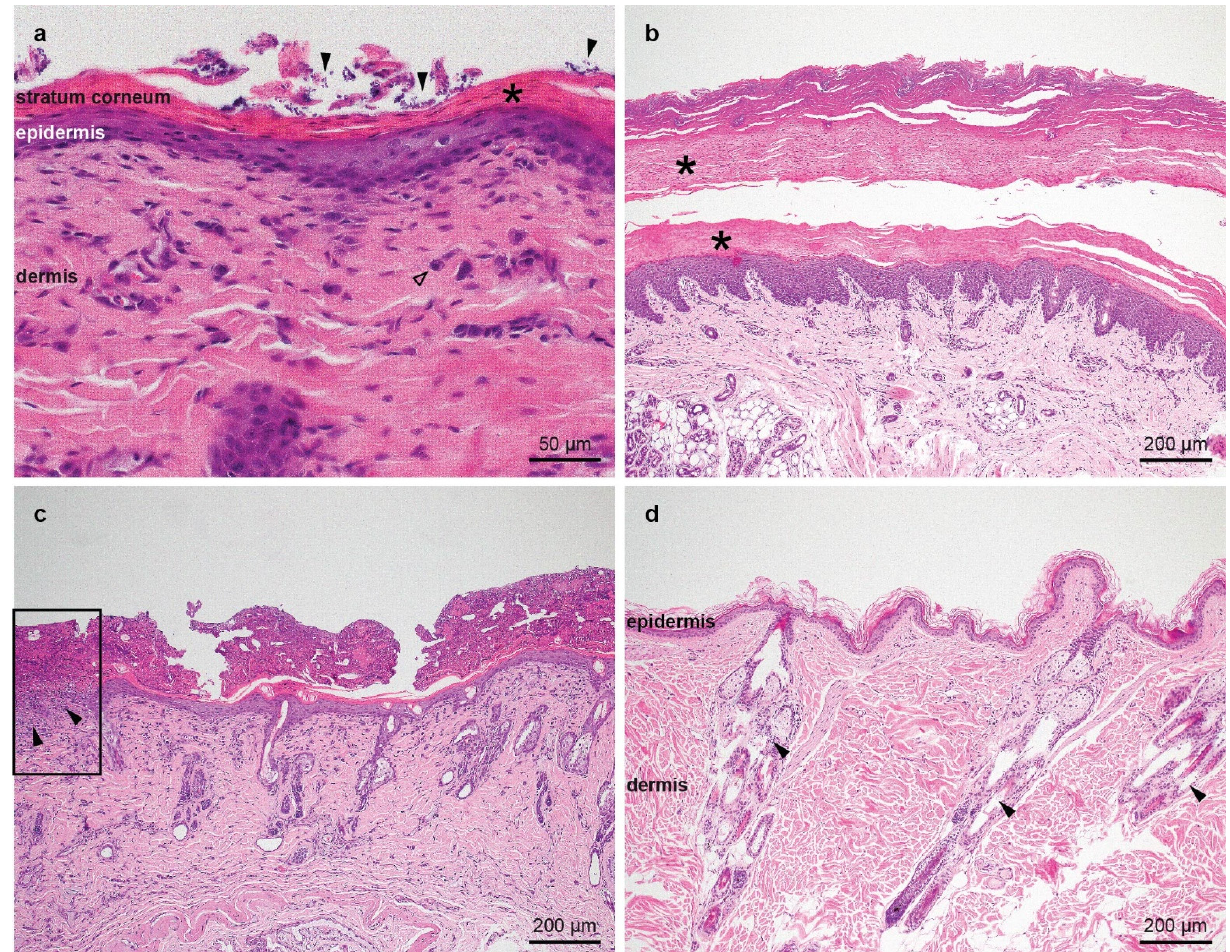
Figure 3. Histopathological images of representative skin biopsies, hematoxillin and eosin stain. ( a ) The epidermis is mildly hyperplastic and covered by compact parakeratotic keratin, characterized by the presence of retained nuclei in the stratum corneum (asterisk). There are numerous yeasts in between the corneocytes, indicated by the filled arrows. There is a mild perivascular infiltrate in the superficial dermis composed mostly of mast cells (empty arrow). ( b ) The epidermis of the paw pad is mildly hyperplastic and covered by a thick layer of compact parakeratotic keratin (asterisks). ( c ) The epidermis is mildly hyperplastic and covered by a thin layer of compact parakeratotic keratin. The stratum corneum is covered by a thick serocellular crust, composed of corneocytes, proteinaceous material, degenerate inflammatory cells, and abundant cocci. In the rectangle on the left edge of the image, an ulcer is present, characterized by the lack of the epidermis and abundant inflammatory cells in the superficial dermis underneath the ulcer (filled arrows). ( d ) Skin of a healthy cat as control showing the epidermis of normal thickness covered by basketweave orthokeratotic keratin together with the dermis and the adnexa (filled arrows).